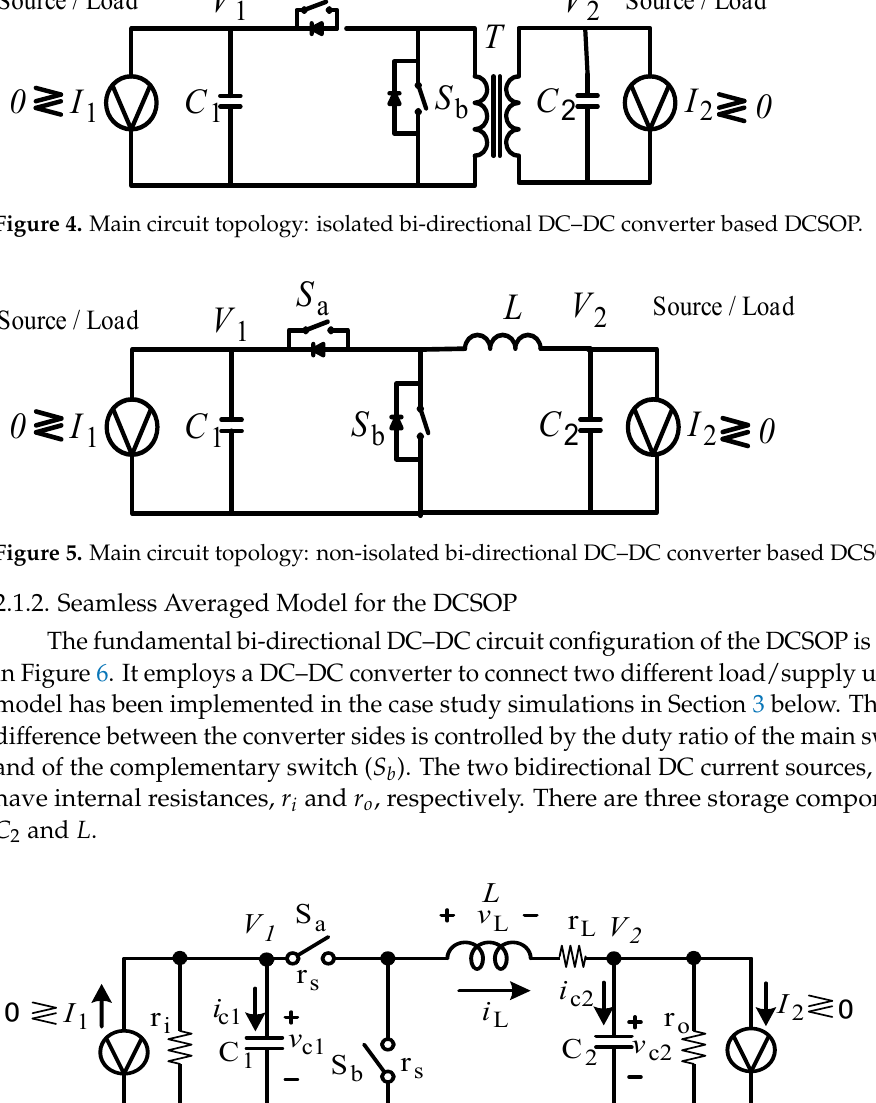
are in- are in- 𝑟𝑟 𝑠𝑠 𝑟𝑟 𝑠𝑠